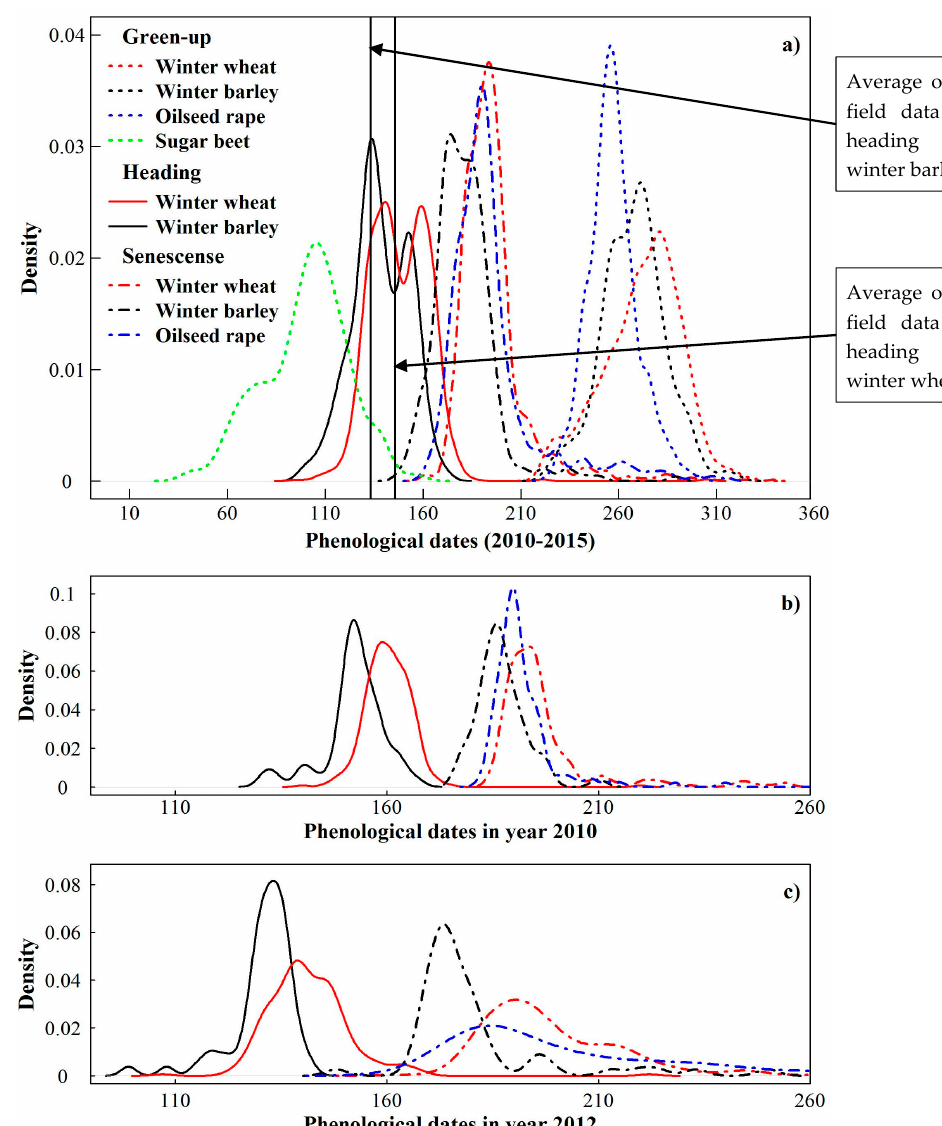
Figure 7. Density of different phenometrics calculated using fields with homogeneous MODIS pixels: ( a ) from 2010 to 2015, ( b ) from 2010 and ( c ) from 2012. The averages of all field data for heading of winter wheat (133.3) and winter barley (145.8) are also shown. The green-up dates of all four major crops within fields with homogeneous MODIS pixels in this region showed the largest mean standard deviation of 12.5 days, followed by the senescence dates (mean standard deviation 7.1 days). The smallest variance occurred in heading of winter cereals (average standard deviation: 5 days). The within-field variability was to some extent affected by the uncertainty of phenometrics calculation, especially for the green-up, which showed relatively high RMSE values on the whole.